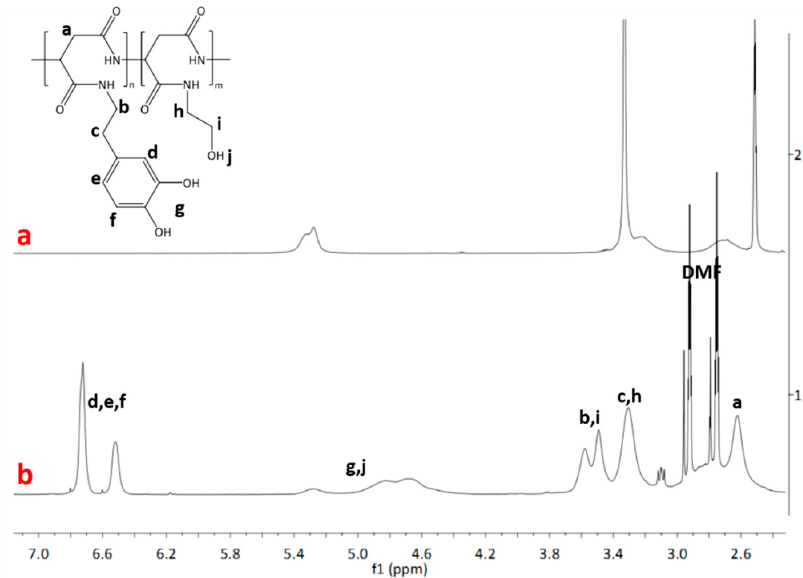
Figure 1. 1 H-NMR spectra of polysuccinimide (PSI) ( a ) and dopamine-conjugated polyAspAm derivative ( b ).